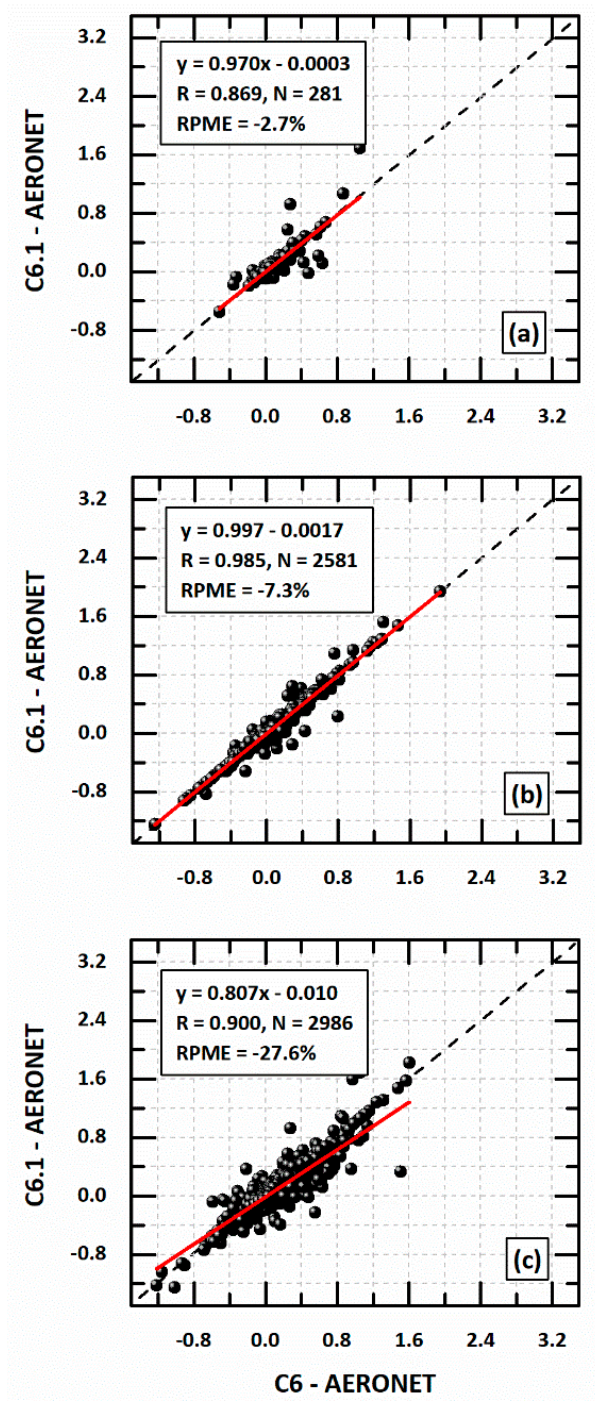
Figure 4. Differencing scatter plots between (C6 – AERONET)- and (C6.1 – AERONET)-collocated AOD retrievals, for, ( a ) DT AOD, ( b ) DB AOD, and ( c ) DTB AOD. The red and dotted black lines represent the regression and 1:1 lines, respectively.